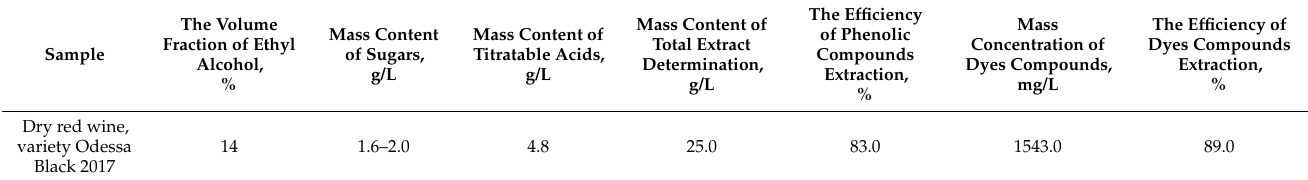
Table 1. Physical and chemical properties of samples of dry wine made from Odessa Black grapes harvest in 2017.